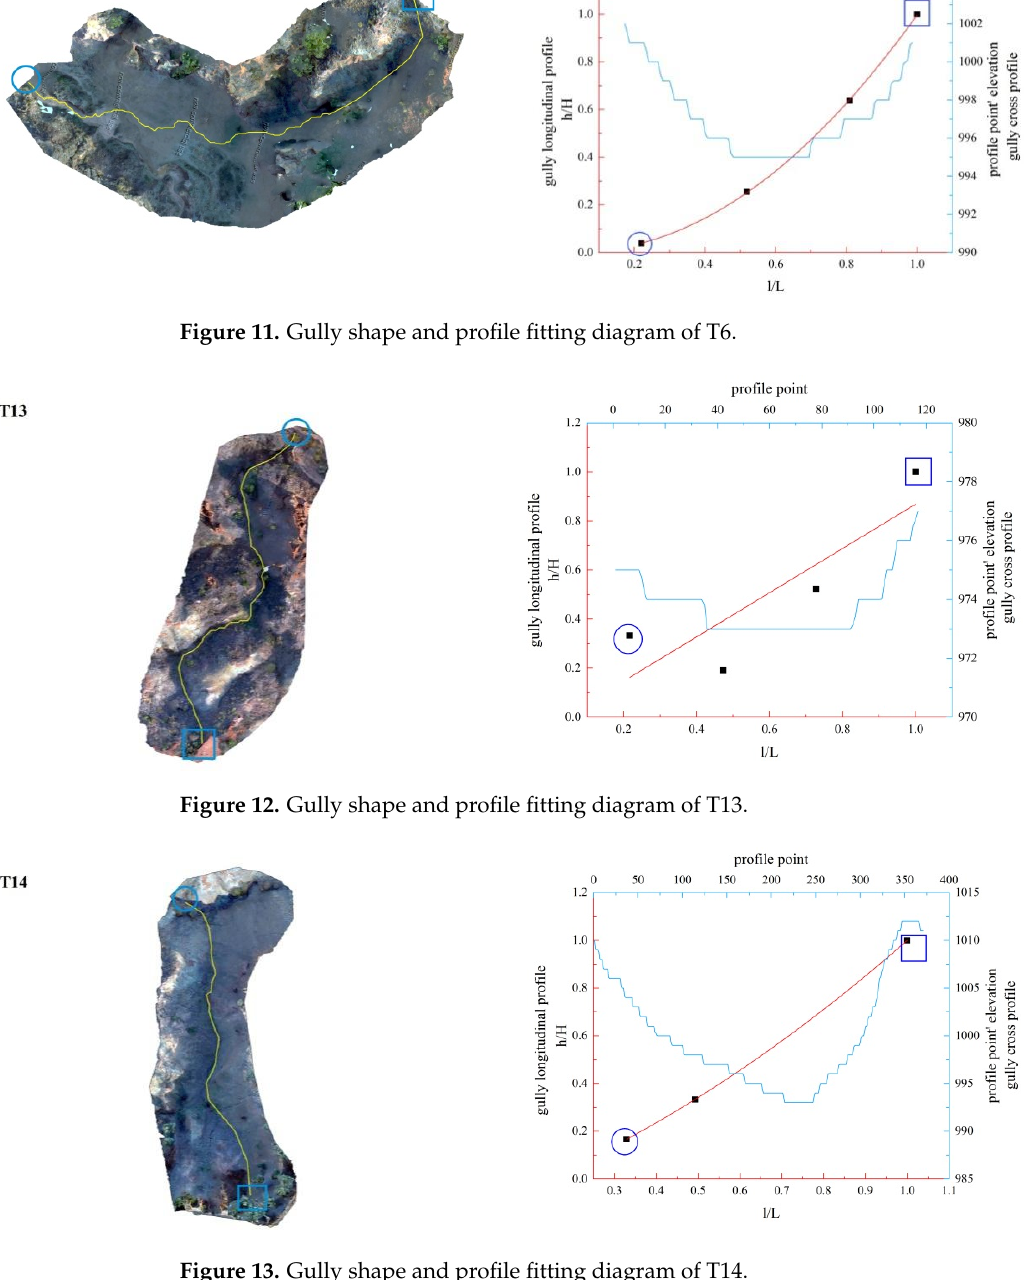
Figure 13. Gully shape and profile fitting diagram of T14.